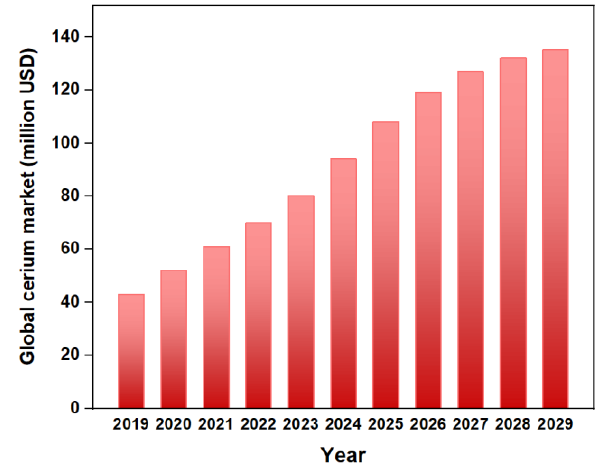
Figure 3. Current and future trends in the global cerium market.